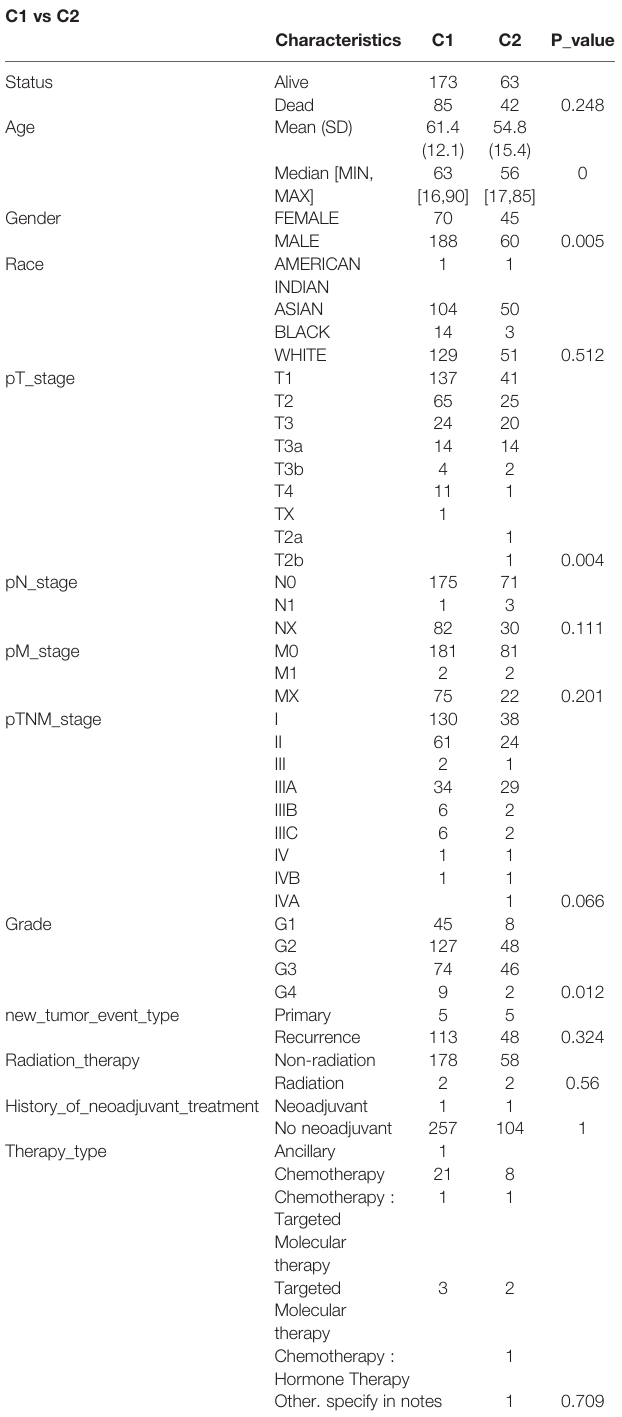
TABLE 1 | Comparisons of clinical characteristics between C1 and